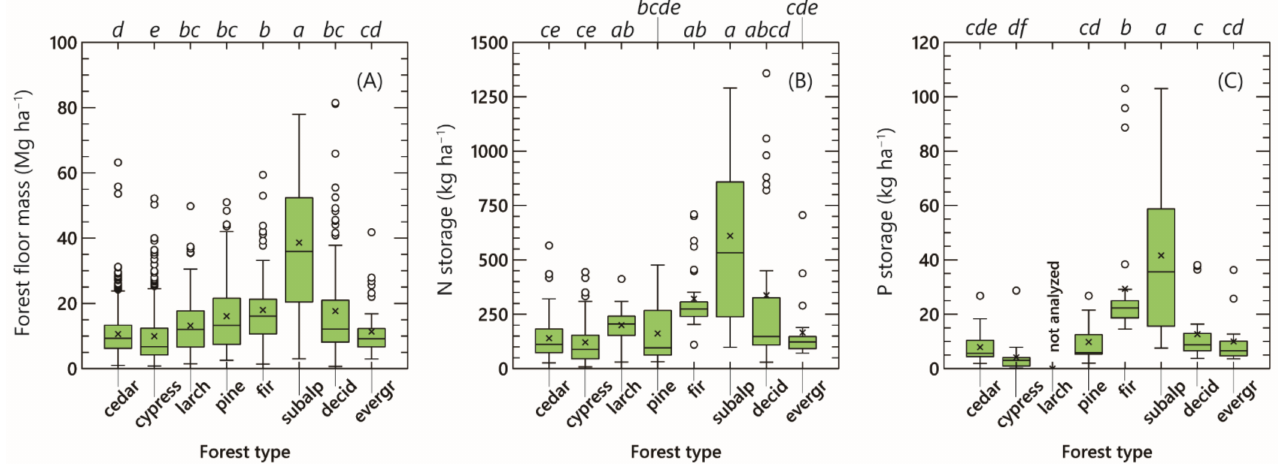
Figure 2. Box and whisker plots of forest floor mass ( A ), nitrogen ( B ), and phosphorus ( C ) storage in the forest floor among Japanese forest types. Subalpine coniferous forests, deciduous broad-leaved forests, and evergreen broad-leaved forests are represented by “subalp”, “decid”, and “evergr” respectively. The box covers the 75th and 25th percentiles. The horizontal line within the box marks the median, and the cross indicates the mean. The length of the whisker is 1.5 times the interquartile range. Outliers are indicated by open circles. Different lowercase letters on the figure denote significant differences between forest types at p < 0.05 based on the Steel–Dwass